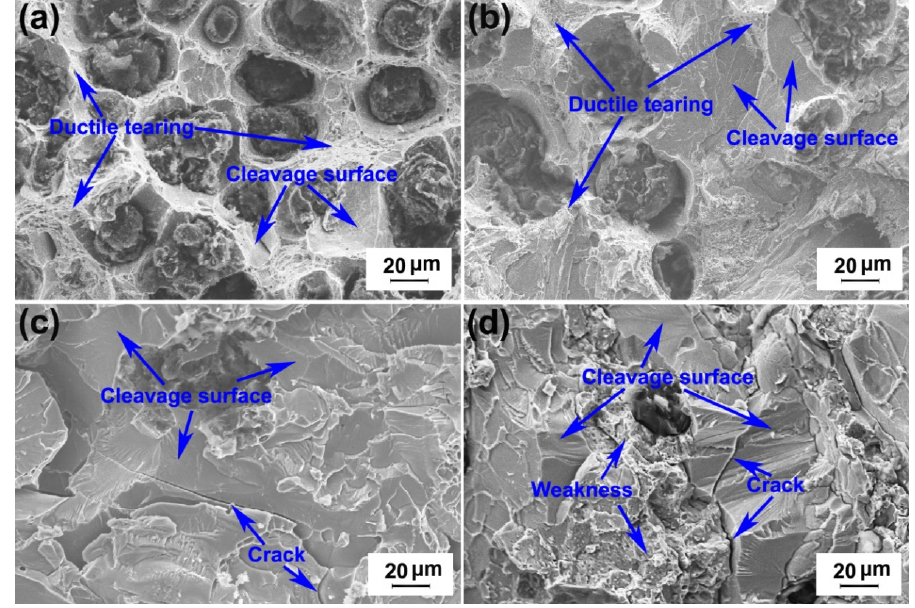
Figure 12. Tensile fracture surface morphology of DI after injecting nitrogen gas for different time periods: ( a ) 0 min; ( b ) 20 min; ( c ) 40 min; ( d ) 60 min.